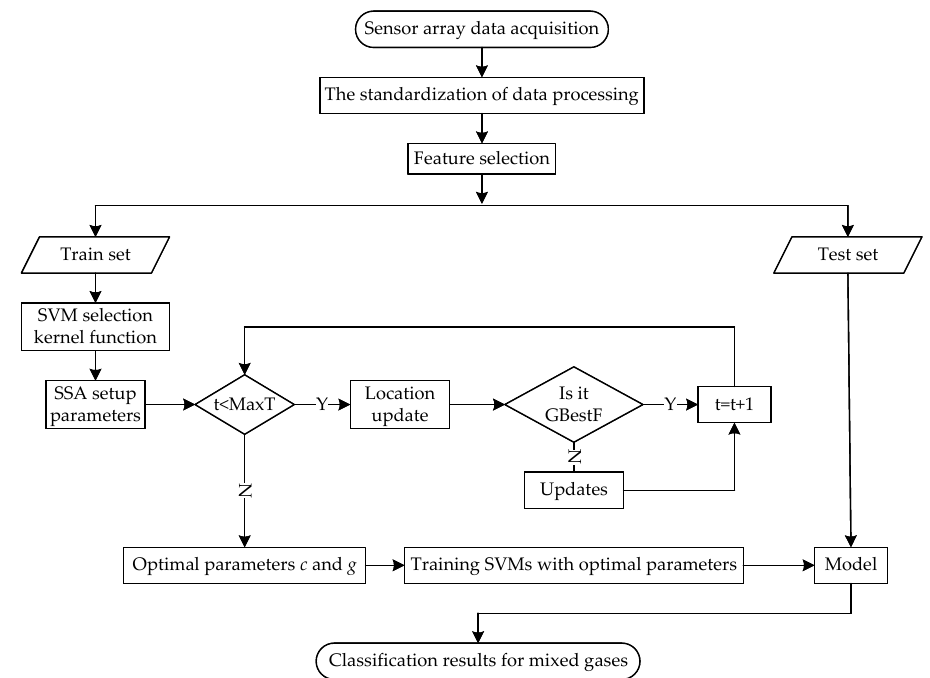
Figure 1. The SSA-SVM mixed-gas-identification